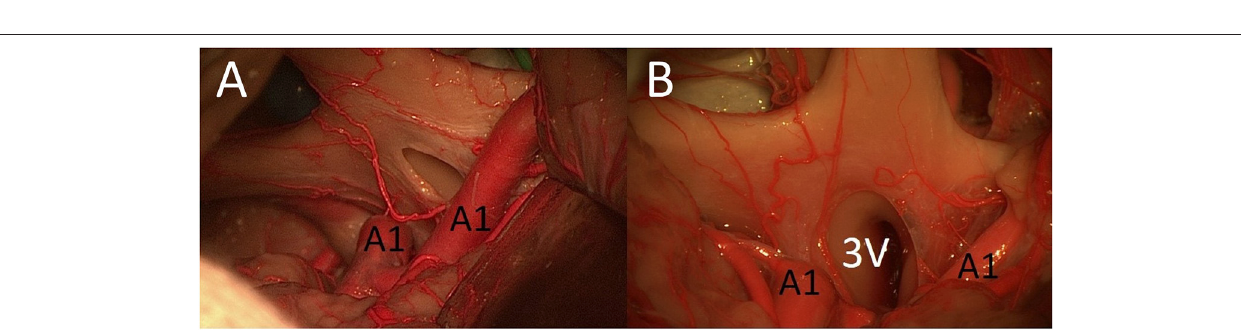
FIGURE 5 | (A) MSO and PT approaches allowed access to contralateral lesions of the third ventricle through the lamina terminalis. (B) The FM approach was the best way to reach deep lesions of the third ventricle through the lamina terminalis (3V, third ventricle; A1, proximal segment of anterior cerebral artery; LT, lamina